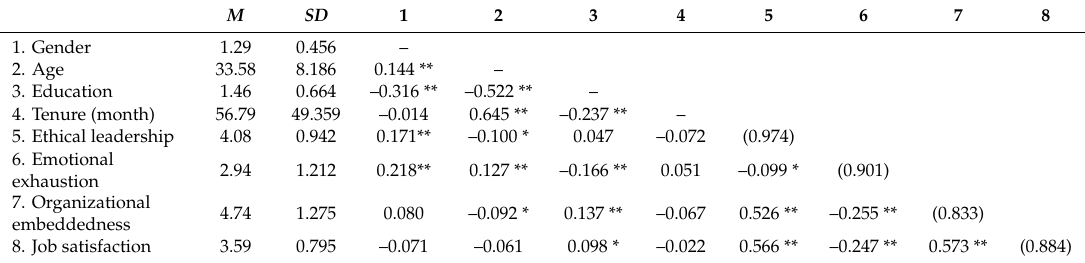
Table 2. Means, standard deviations, and correlations.